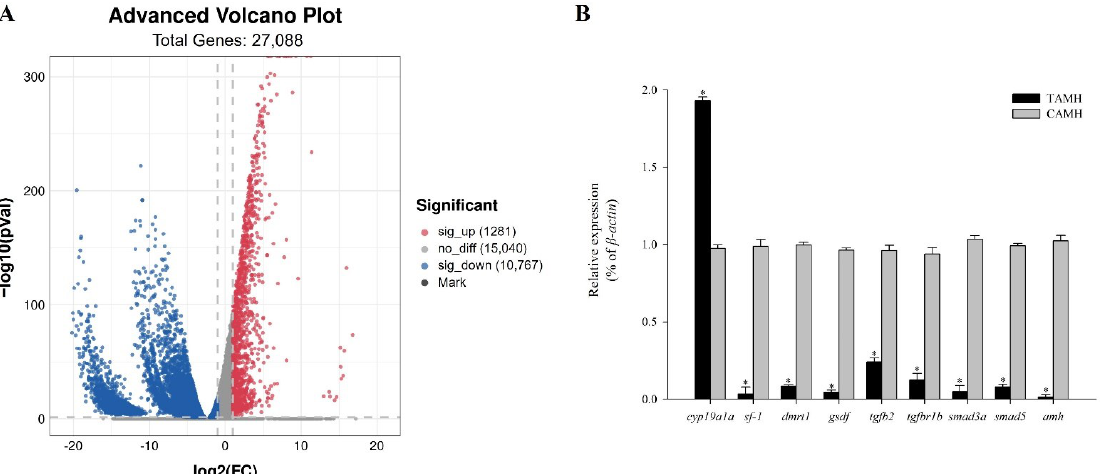
Figure 6. ( A ) Volcano plot of differentially expressed genes (DEGs) in Nile tilapia under knocked- down amh (treatment groups vs. control groups). Dots: blue, down-regulated DEGs in treatment compared with control groups; red, up-regulated DEGs in treatment compared with control groups; gray, genes with no significant difference in expression. ( B ) Transcript levels of differentially expressed genes (DEGs) in males based on qRT-PCR analyses ( n = 9 replicates per group). Nine DEGs were selected for qRT-PCR verification. Asterisk (*) indicates significant difference ( p < 0.05) between TAMH and CAMH.